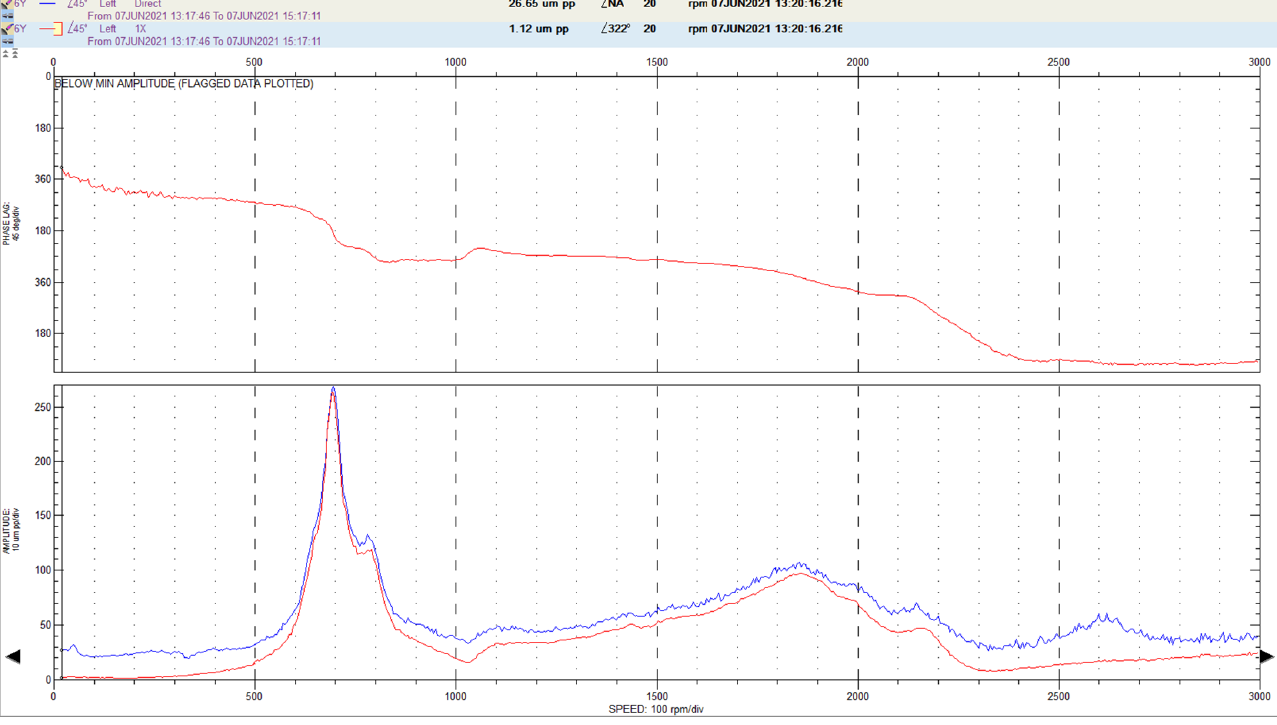
Figure 3. Transient amplitude ‐ phase response (Bodé plot) of the shaft in journal bearing.